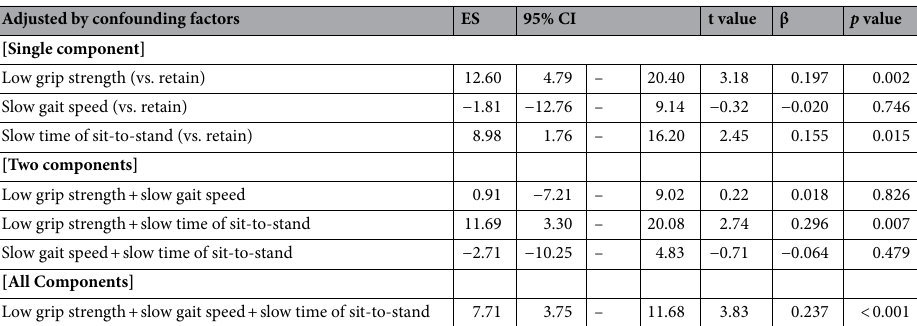
Table 3. The relationship between change in Barthel index score from before to after inpatient rehabilitation and components of muscle dysfunction (low grip strength, slow gait speed, and slow time of sit-to-stand) using multiple regression analysis. Adjusted by Barthel index score before admission, age, sex, body mass index, Mini-Mental State Examination, hypertension, dyslipidemia, diabetes mellitus, albumin, hemoglobin, white blood cell, estimated glomerular filtration rate, and C-reactive protein. CI, confidence interval; ES, estimate value.